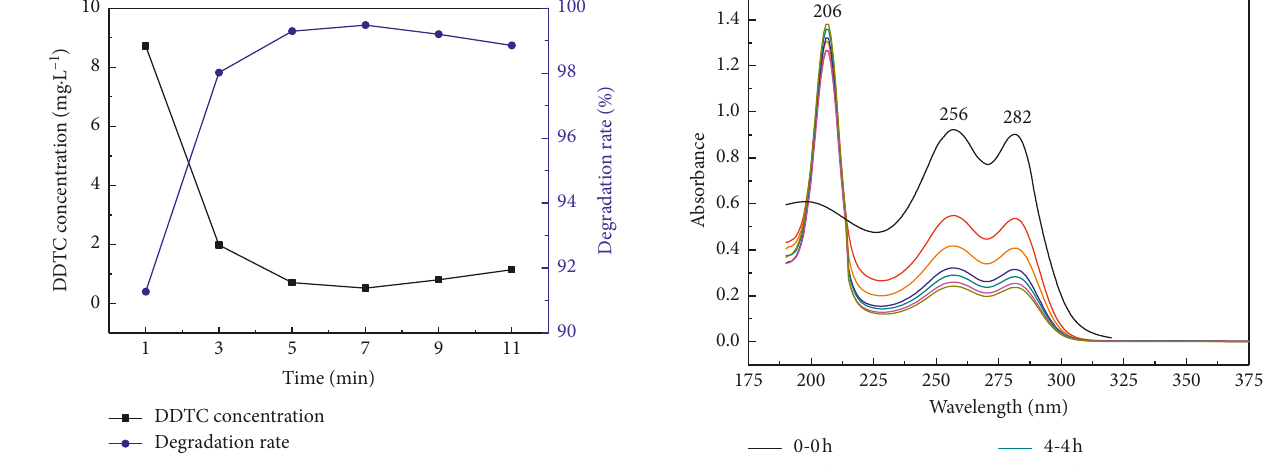
Figure 7: Influence of reaction time on the degradation of